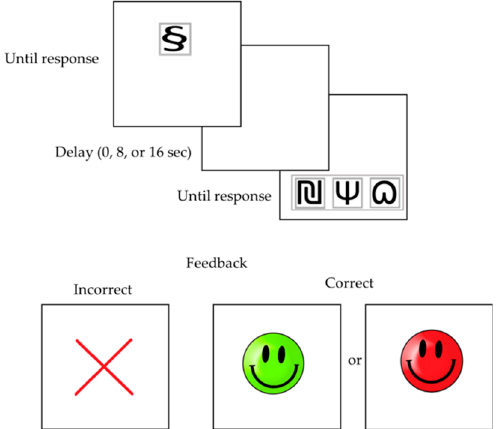
Figure 1. The sequence of the CDL (Conditional Discrimination Learning) task. The sample stimulus was presented together with a sound and remained on the screen until the child responded by touching the stimulus on the touch screen. During the delay (if any), a blank screen was presented. Then, the choice stimuli were presented and remained on the screen until the child responded on the touch screen. Incorrect responses were followed by a red cross, whereas correct responses were followed by a red or green smiley face (random presentation of colors). After 2 s, the next trial was presented.